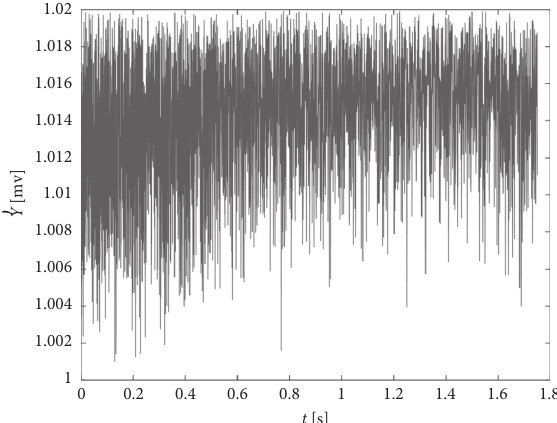
Figure 14: Modulated phases t